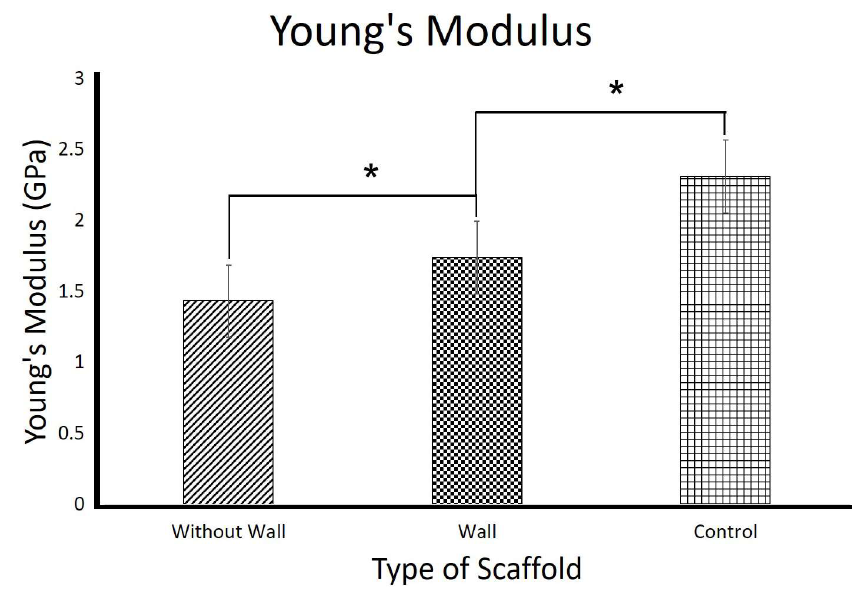
Figure 7. Compressive strength of the 3D scaffolds. (* p < 0.05).